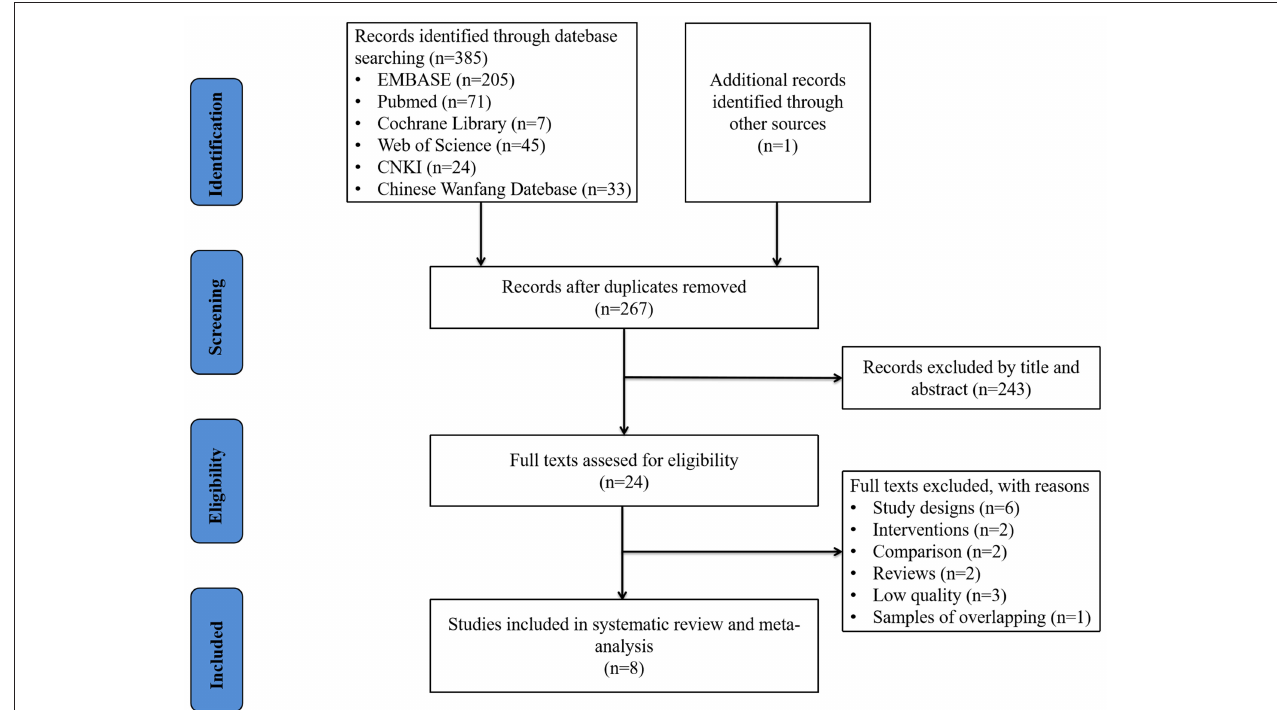
FIGURE 1 | Literature screening process and